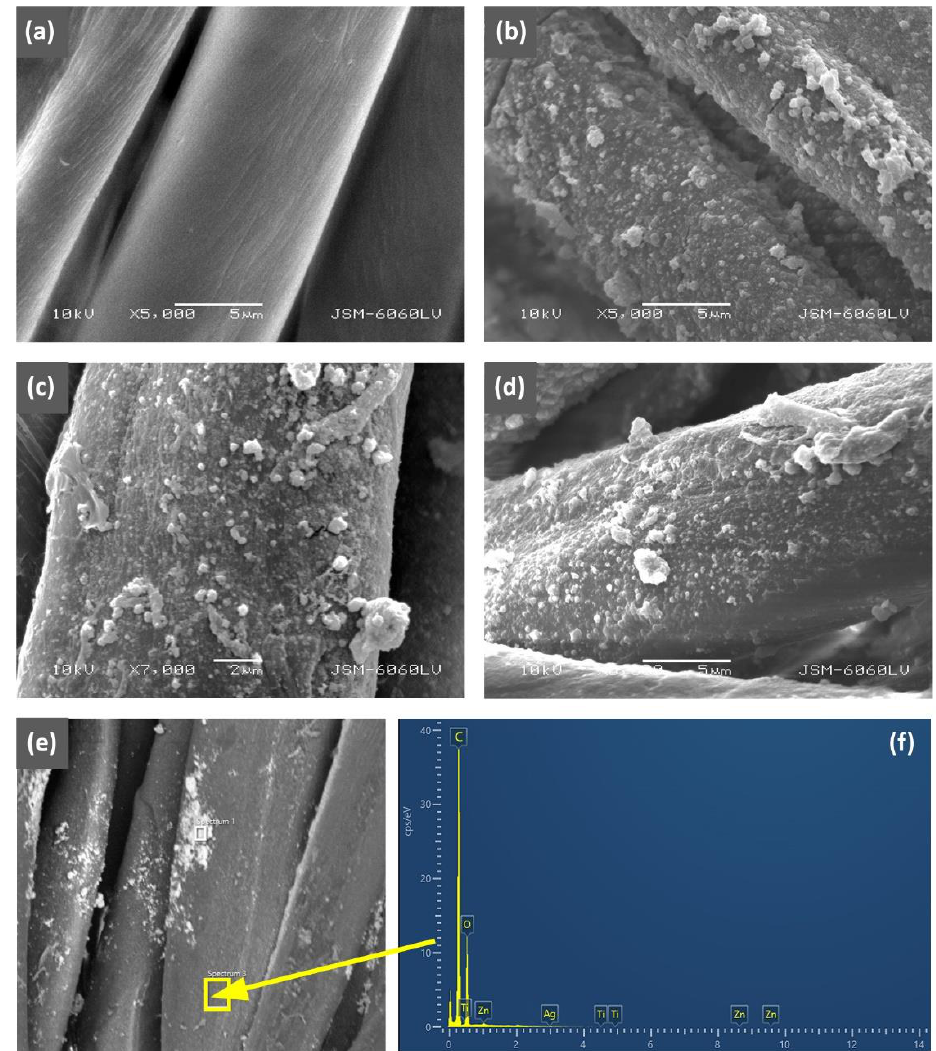
Figure 1. SEM images of untreated ( a ) and chemically modified cotton samples: CO/TiO 2 /Ag ( b ), CO/ZnO/Ag ( c ) and CO/TiO 2 + ZnO/Ag ( d ). SEM/BSE image of CO/TiO 2 + ZnO/Ag sample ( e ). EDS spectrum acquired from CO/TiO 2 + ZnO/Ag sample in place bordered with yellow ( f ).